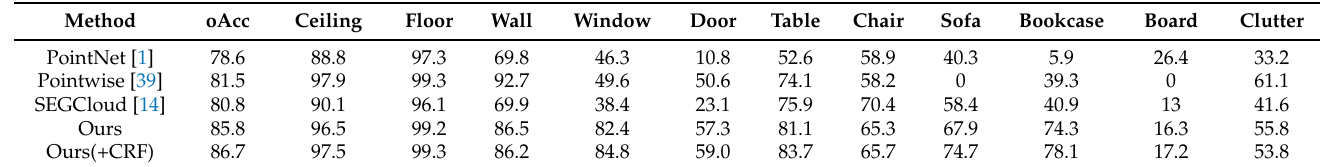
Table 3. Evaluated the accuracy of each of our classes on the S3DIS dataset and compared it to three other networks on S3DIS. Method oAcc Ceiling Floor Wall Window Door Chair Sofa Bookcase Board